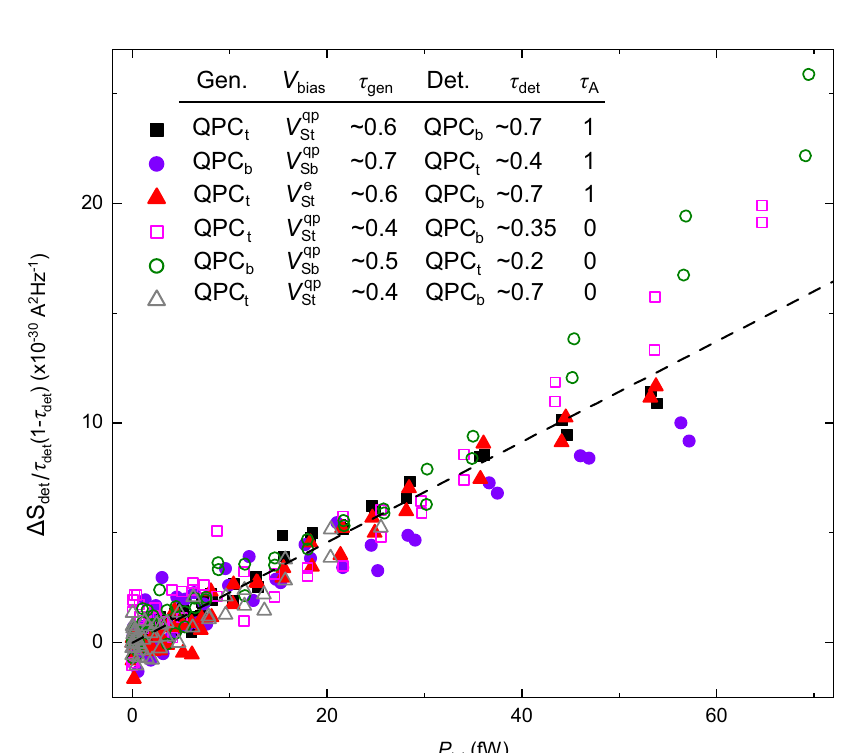
differentialtransmissionratiod I T /d I S asafunctionofthegatevoltage V A g appliedto the two gates controlling the analyzer QPC. The black and red continuous lines correspond to measurements in the presence of a direct dc voltage bias V qp V e μ V and − 43 μ V, respectively. The arrows indicate the approximate S =0 S = working points in the SBS (down arrows) and WBS (up arrow) regimes.